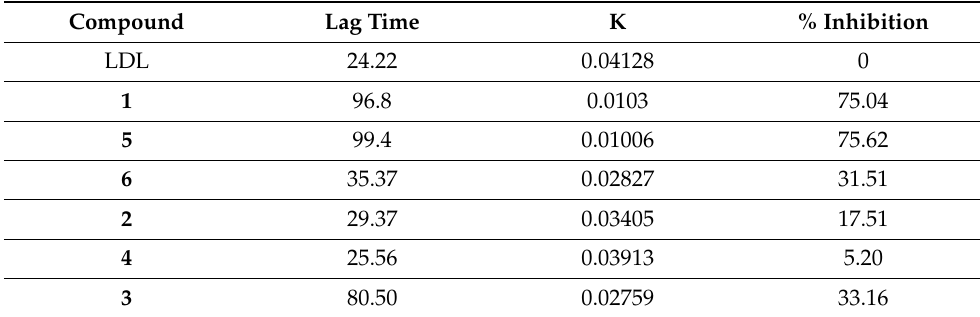
Table 1. Effect of the synthesized lipids on lag time, rate constant of the reaction propagation (K), and % inhibition of LDL oxidation. See Figure 1 for compounds corresponding to each number.